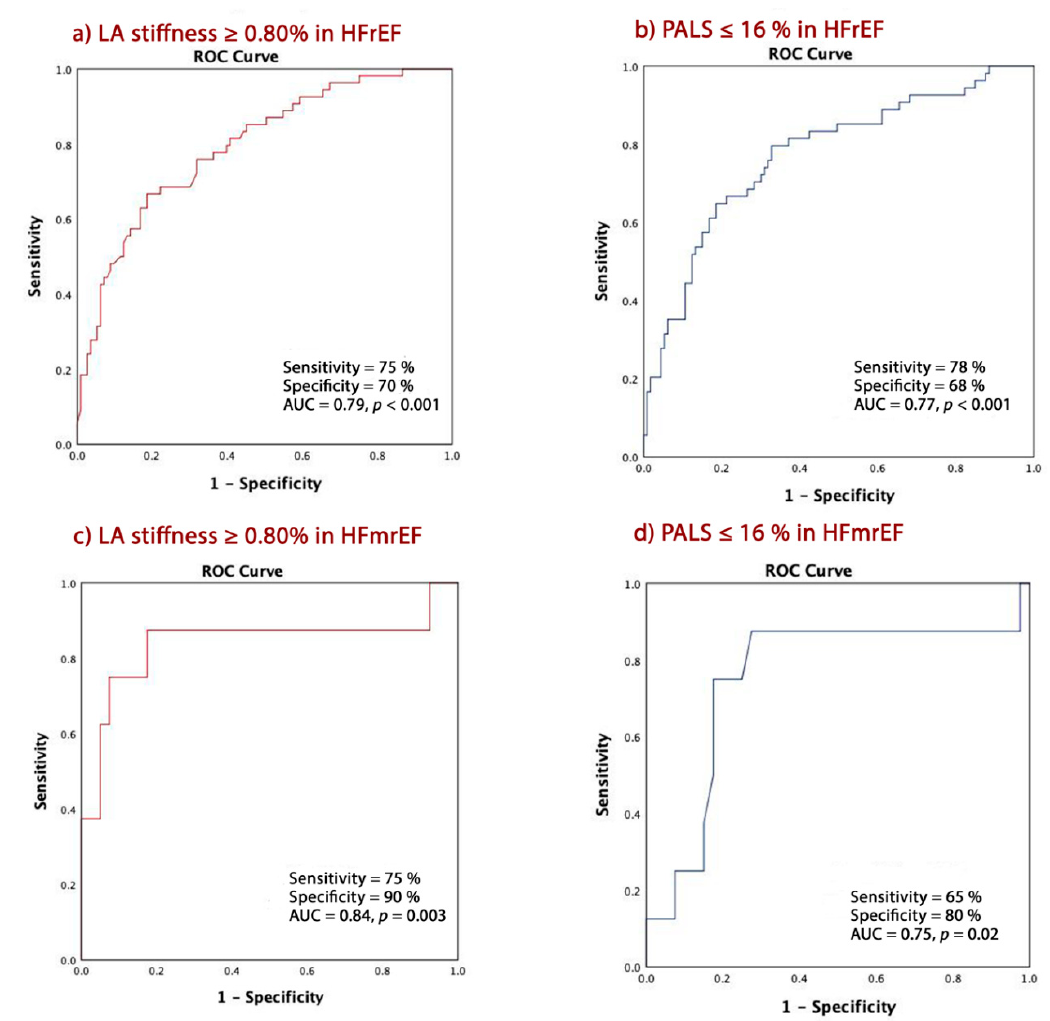
Figure 3. LA stiffness and PALS in predicting cardiac events in patients with HFrEF and HFmrEF; ( a ) LA stiffness ≥ 0.76% in cardiac events in HFrEF; ( b ) PALS ≤ 16 in predicting cardiac events in HFrEF patients; ( c ) LA stiffness ≥ 0.76% in cardiac events in HFmrEF; ( d ) PALS ≤ 16 in predicting cardiac events in HFmrEF patients.